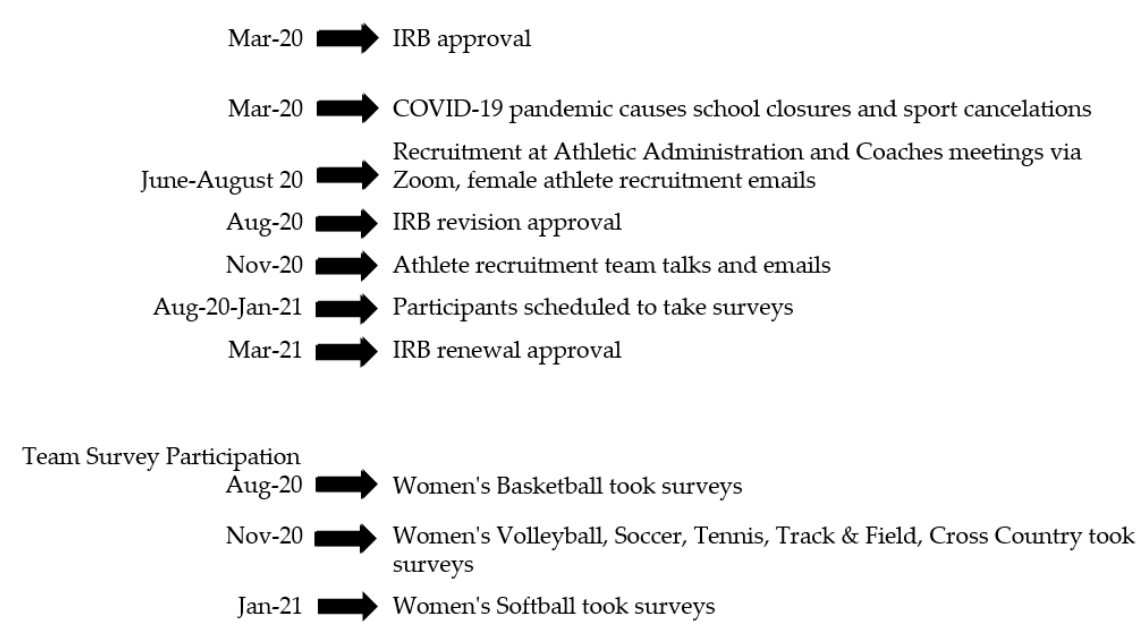
Figure 2. Study Timeline.